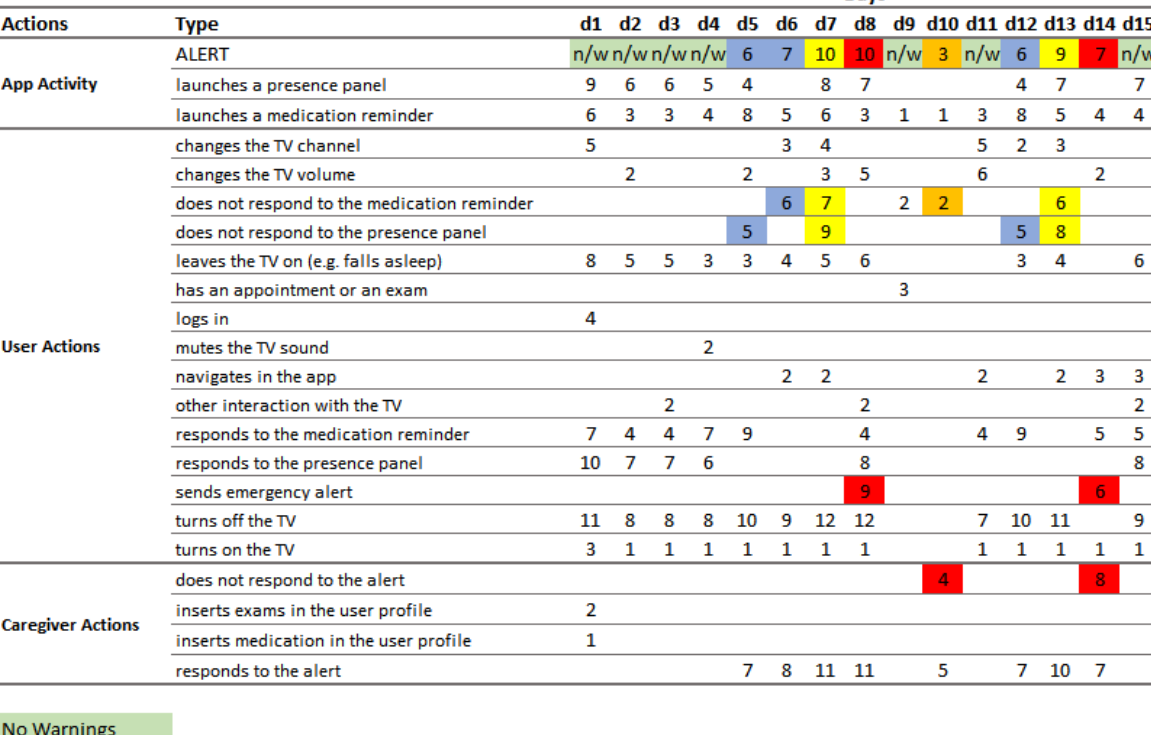
Figure 20. Analysis grid of the warning algorithm’s behavior.